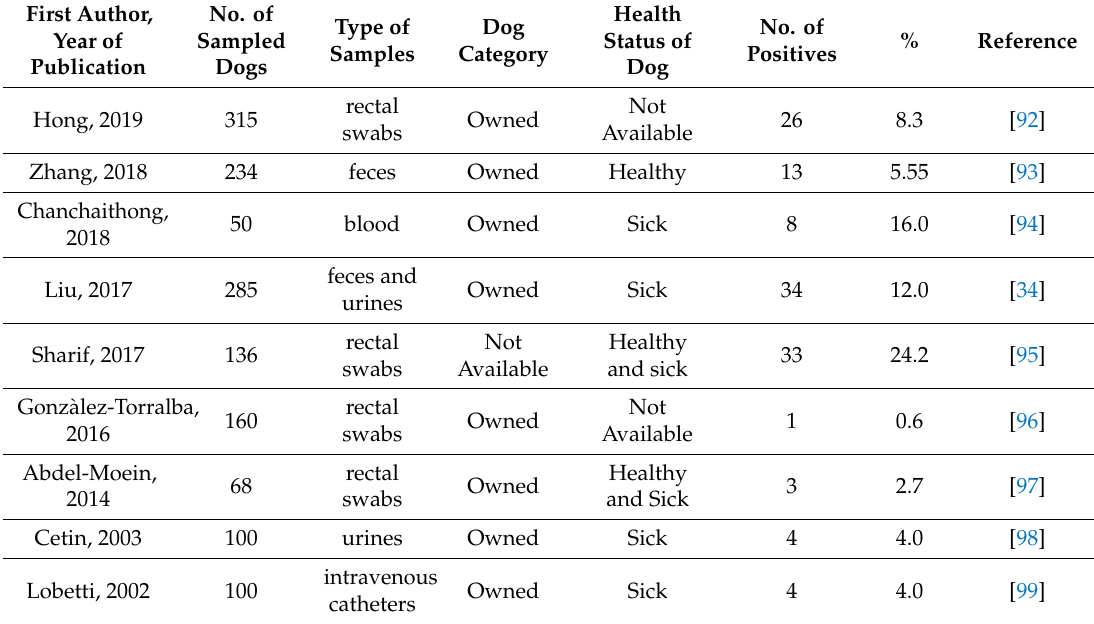
Table 4. Data of the included articles regarding the presence of Klebsiella pneumoniae in dogs.